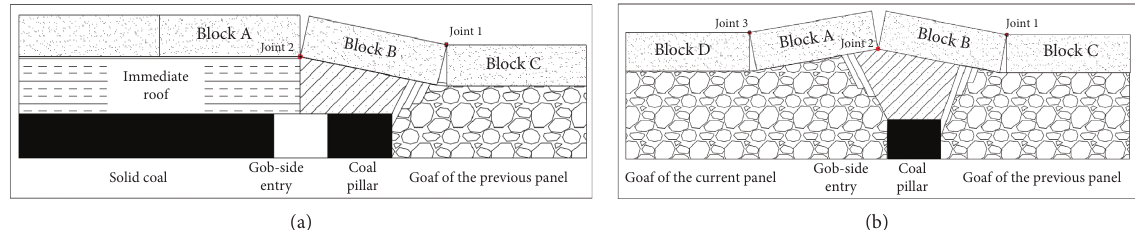
Figure 1: Structure model of overlying strata in the gob-side entry. (a) The fracture model of the main roof in the adjacent face. (b) The fracture model of the main roof in this face.